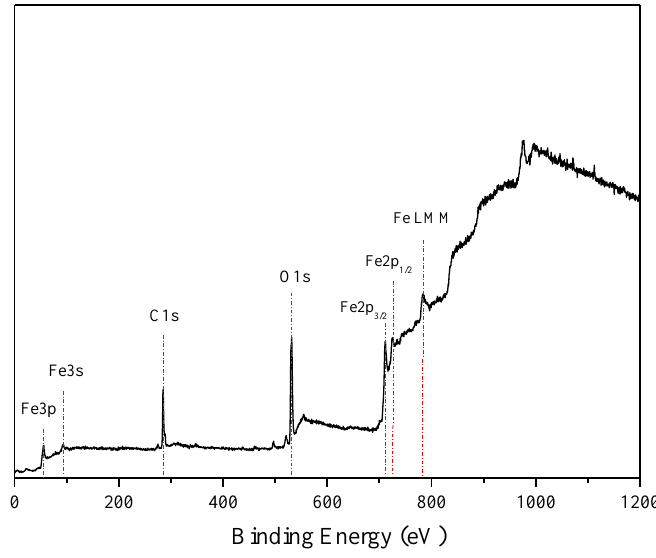
Figure 7. Wide XPS scan of AISI 1045 carbon-steel polished referent samples.